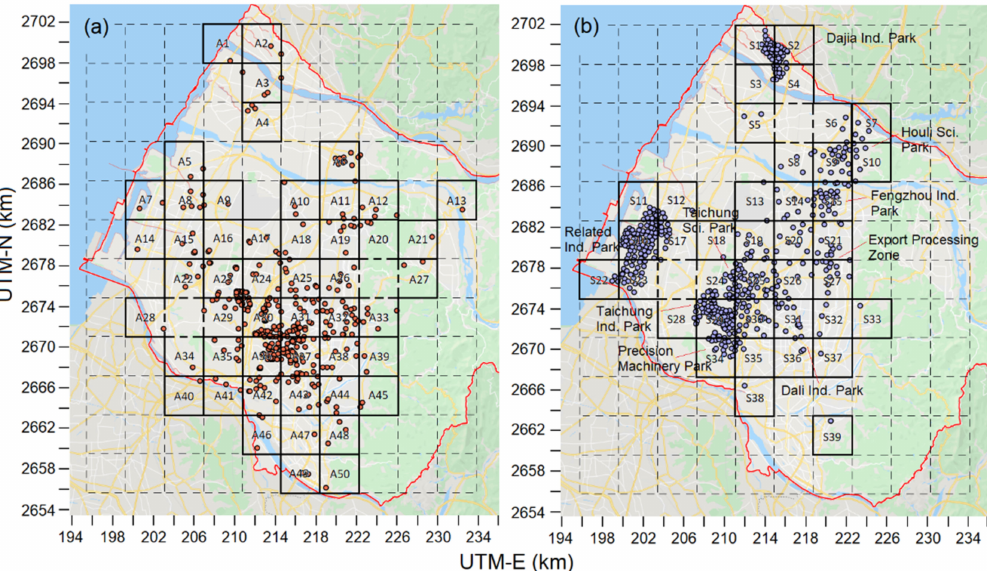
Figure 9. Clustering of low-cost PM 2.5 sensors. ( a ) AirBox and ( b ) SAQ-200. Solid boxes are the clustered squares for low-cost PM 2.5 sensors.